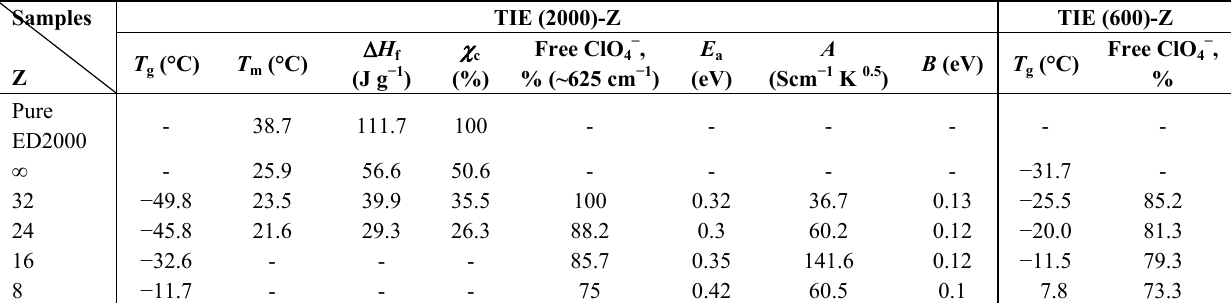
), melting temperature ( T g